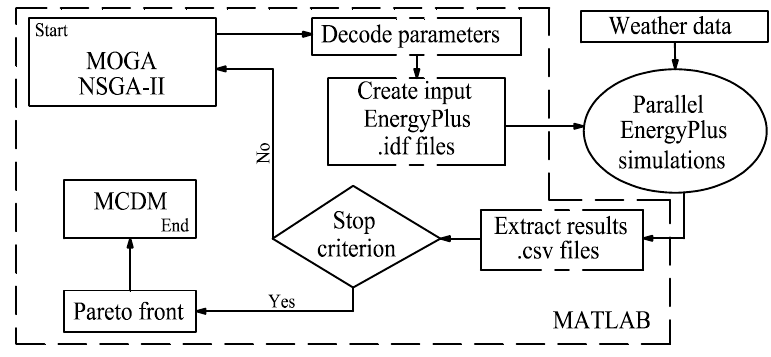
Figure 3. Connection diagram for MATLAB–EnergyPlus.